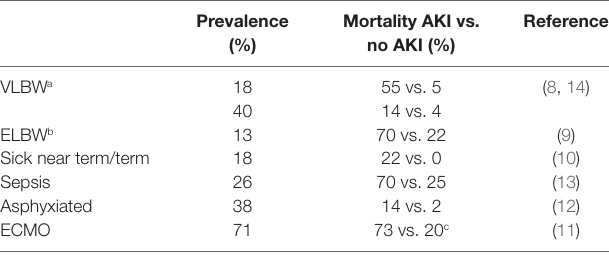
tablE 1 | neonatal aKi prevalence and mortality rates.